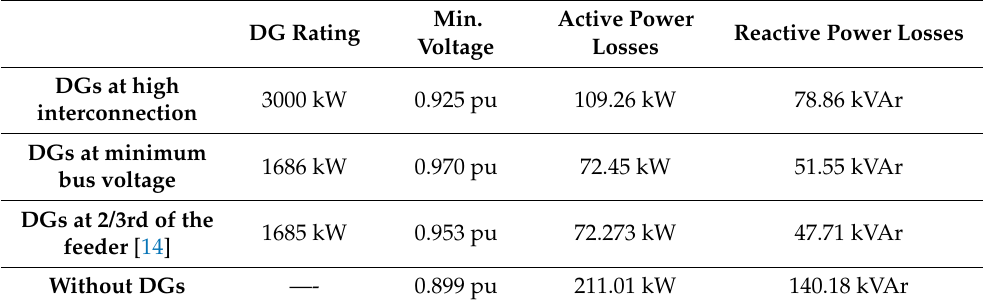
Table 6. Summary of the load flow results at the nominal loading condition (100% loading) or a total connected load of (3581 + j1745) kVA. connected load of (3581 + j1745) kVA.